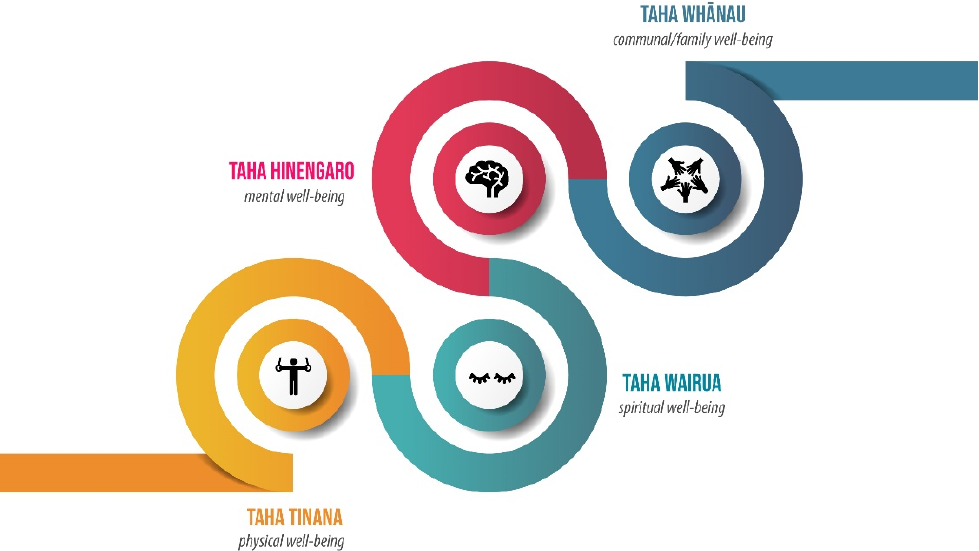
Figure 2. Fundamental aspects of Māori health and wellbeing.